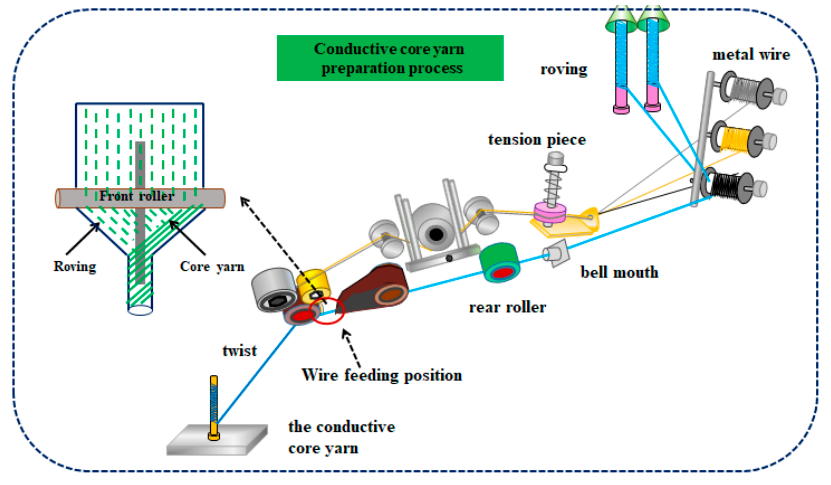
Figure 1. The schematic diagram of the preparation process for conductive wrapped yarn.